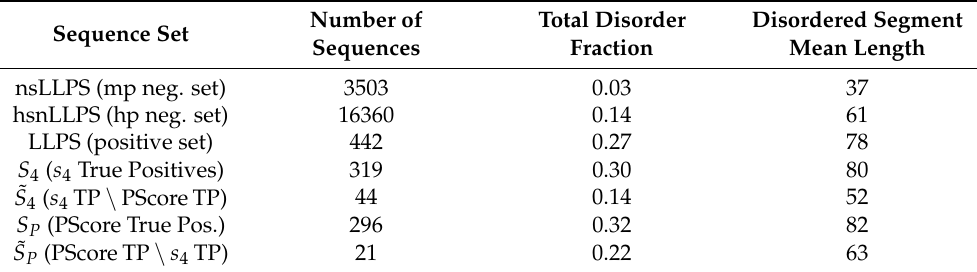
Table 5. Intrinsic disorder prediction for different sequence sets used in this work. The 3.10.0 release of the MobiDB-lite consensus predictor was used [38]. The sets ˜ S 4 , ˜ S P , S 4 , S P were defined in Section 3.5, such that ˜ S 4 ⊂ S 4 , ˜ S 4 ∩ S P = ∅ , ˜ S P ⊂ S P , ˜ S P ∩ S 4 = ∅ . hp = human proteome; mp = mixed proteomes; TP = true